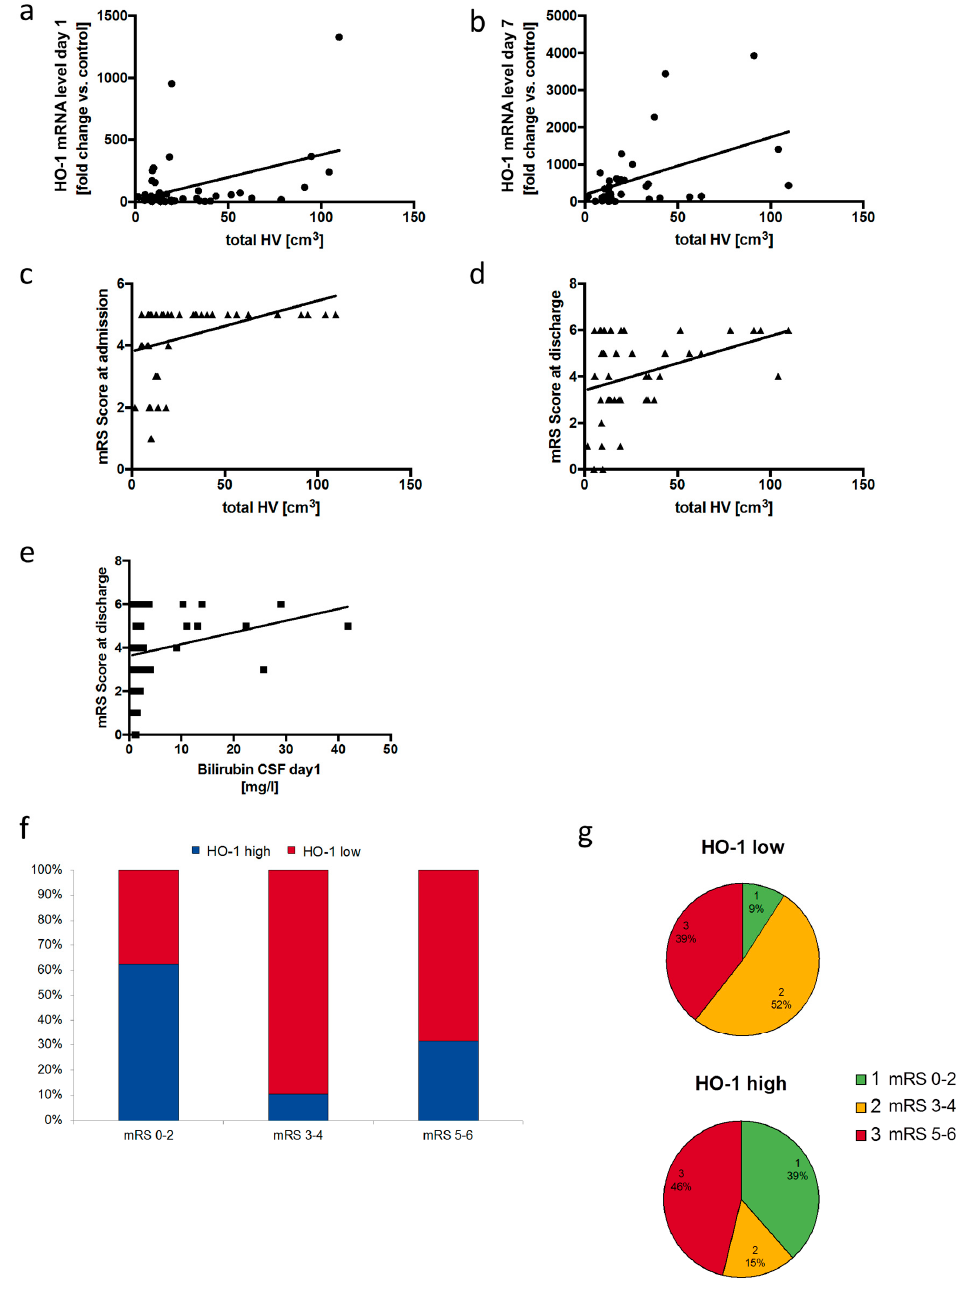
Figure 7. Correlation of HO-1 in the CSF of SAH patients with neurological outcome. ( a , b ) Correlation of HO-1 mRNA level in cells of the CSF from patients with SAH on day 1 after hemorrhage ( a ) and day 7 ( b ) with the total hematoma volume observed on the initial CT scan (Spearman correlation, r = 0.17, p = 0.3 for day 1; r = 0.42, p = 0.02 for day 7). ( c , d ) Correlation of the modified Rankin Scale (mRS) score from patients with SAH on admission ( c ) and discharge ( d ) with the total hematoma volume observed on the initial CT scan (Spearman correlation, r = 0.47, p = 0.001 for admission mRS; r = 0.32, p = 0.03 for discharge mRS). ( e ) Correlation of the mRS score at discharge from patients with SAH with bilirubin content in the CSF on day 1 after hemorrhage (Spearman correlation, r = 0.28, p = 0.04). ( f , g ) Frequencies of relative HO-1 mRNA level categories (HO-1 low vs. HO-1 high) within the observed mRS score groups in SAH patients at discharge ( f ) and distribution of the observed mRS score categories within the relative HO-1 mRNA level groups ( g ) in SAH patients at discharge (x 2 test for sampling distribution (df = degrees of freedom); both x 2 (2) = 7.677, p =